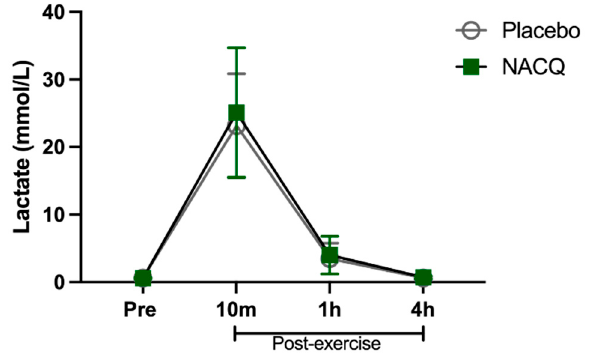
Figure 1. The concentration of plasma lactate in horses supplemented with NACQ compared to placebo before, during, and after an exercise test at a maximal gallop. Lactate concentrations were significantly higher 10 min post-exercise than all other timepoints ( p < 0.0001) and were not significantly different between placebo and NACQ.